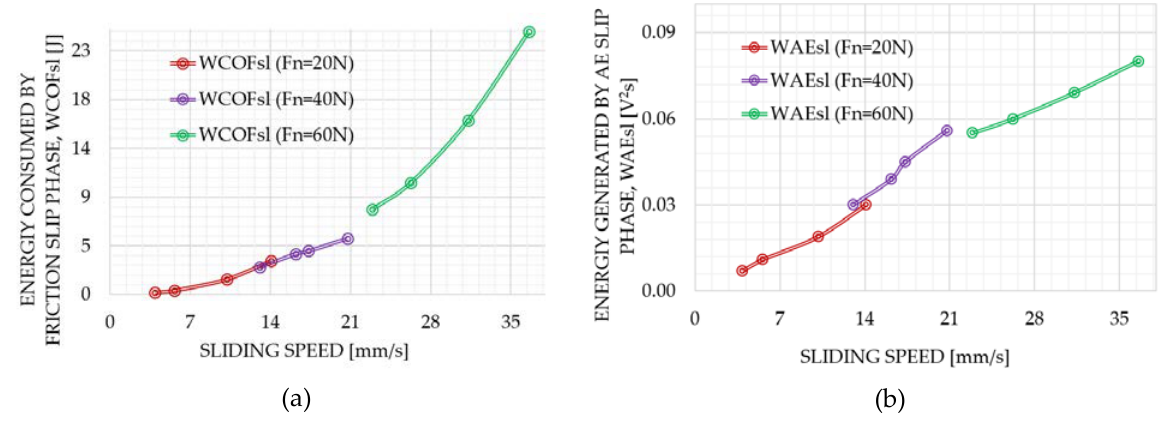
Figure 11. Variation in COF ( a ) and AE ( b ) energies with sliding speed.